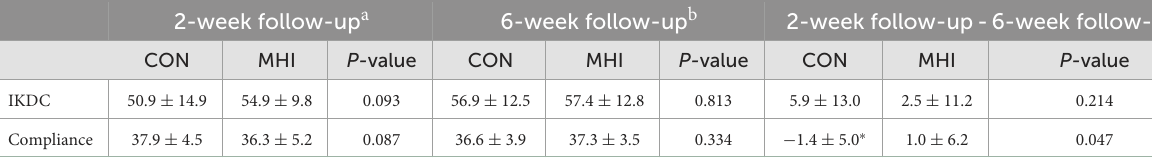
TABLE 3 IKDC and compliance scores at 2 and 6 weeks follow-up (mean ±